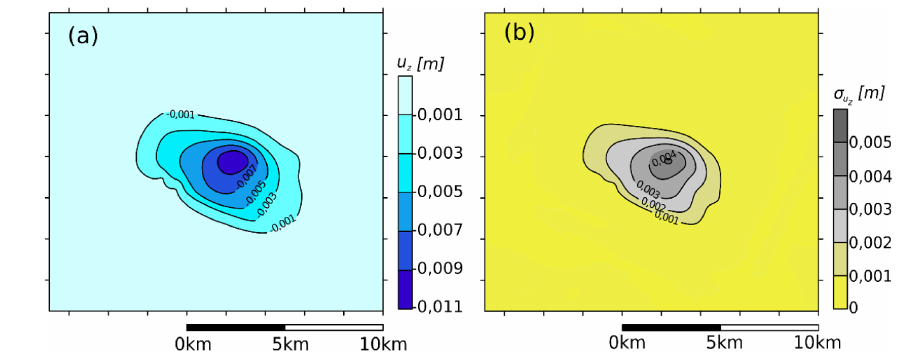
Figure 3. Test case 1: (a) mean and (b) standard deviation ( σ z ) from the forecast ensemble of the vertical displacement ( u z ).